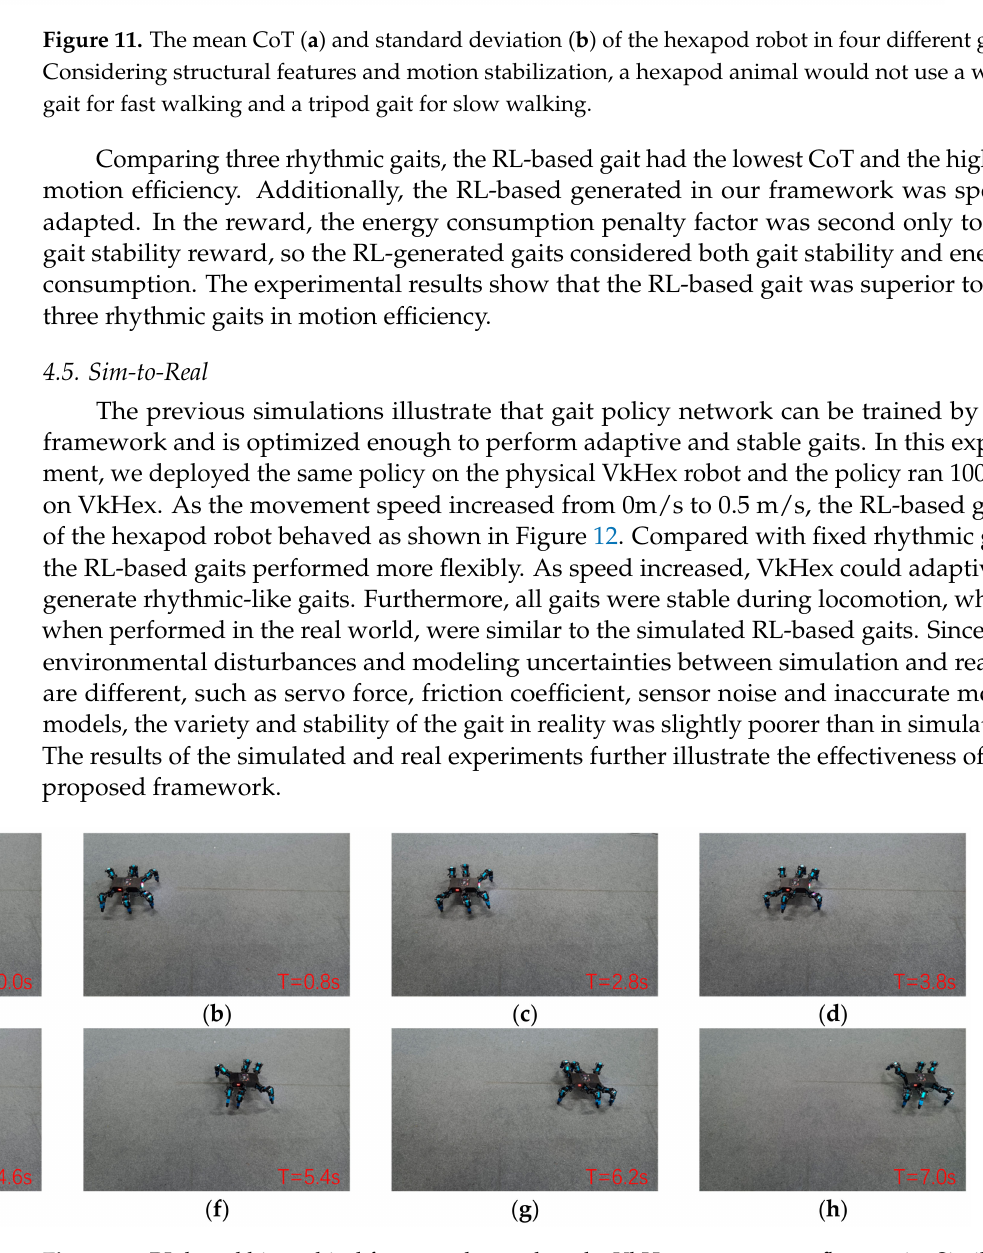
Figure 12. RL-based hierarchical framework tested on the VkHex prototype on flat terrain. Similarly, from ( a – h ), the robot walked in a fixed direction while the motion speed gradually increased to 0.5 m/s. The hexapod robot walked primarily in a triangular-like gait and slightly to the